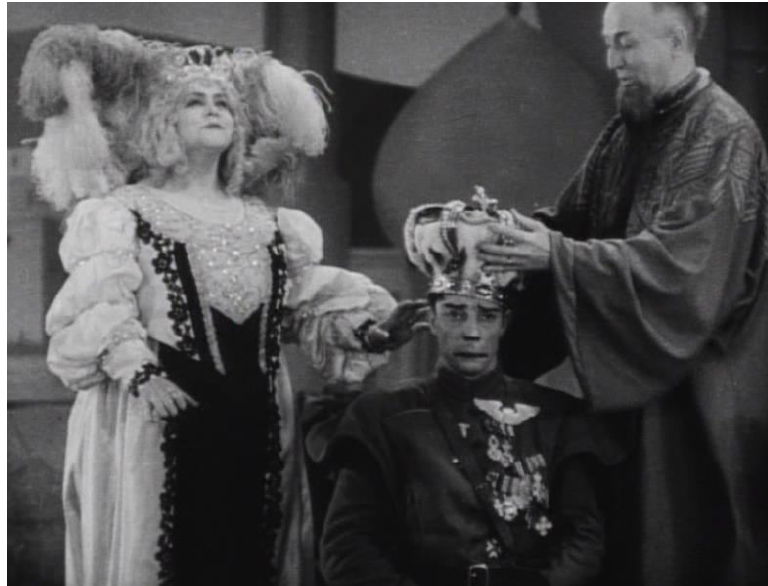
Figure 3. In the film-in-the-film of Free and Easy , Elmer is crowned king of a mythical